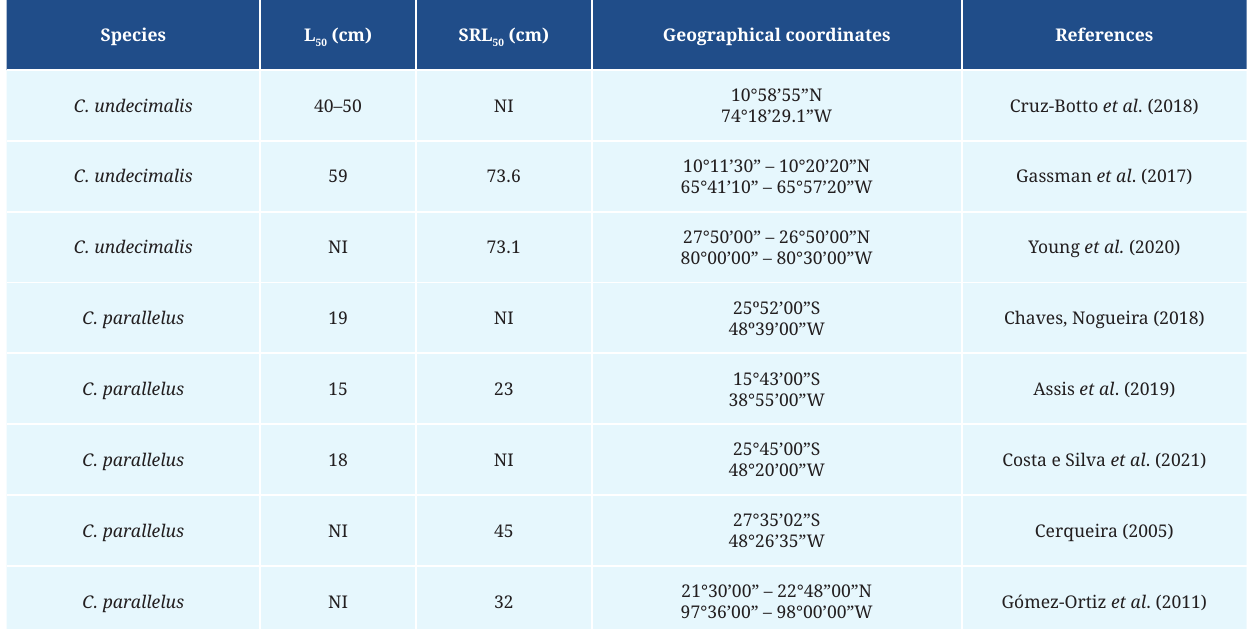
TABLE 3 | Reproductive parameters of Centropomus undecimalis and C. parallelus . L sexual reversal of males into active female size; NI = Not